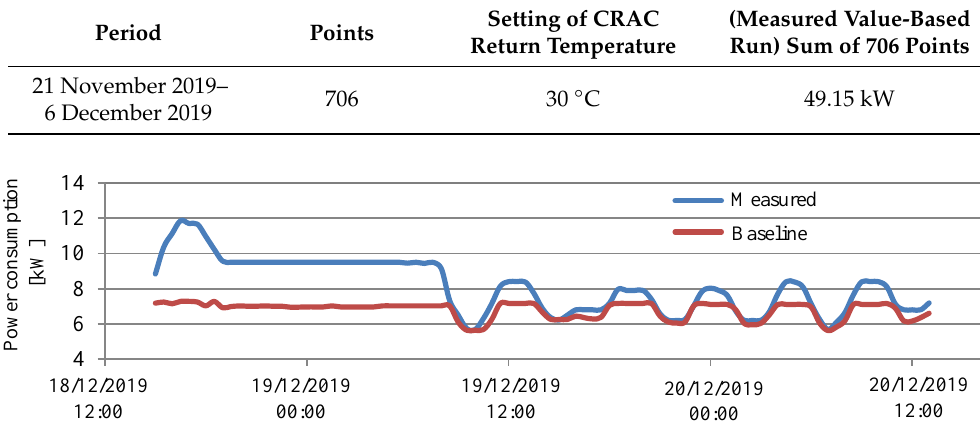
Figure 15. Comparison of measured power consumption and baseline time-series change when CRAC return temperature is changed to 30 °C.